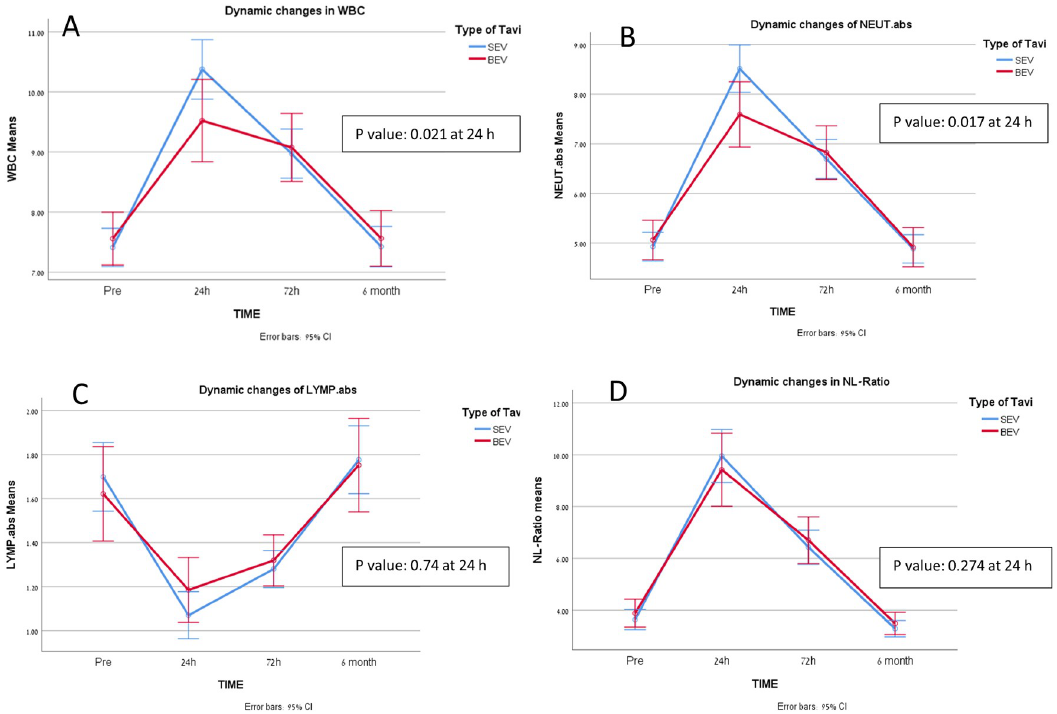
Fig 3. Difference in two types of expandable system for leukocytes and its components after TAVI, (A) difference in total WBC with time, (B) difference in Neutrophils with time, (C) difference in lymphocytes with time, (D) difference in NL ratio with time. SEV = Self Expandable Valve; BEV = Balloon Expandable Valve; LYMP. abs = Absolute Lymphocytes (K/uL); NEUT. abs = Absolute Neutrophils (K/uL); WBC = White Blood Cells (K/uL); NLR = Neutrophils to Lymphocytes